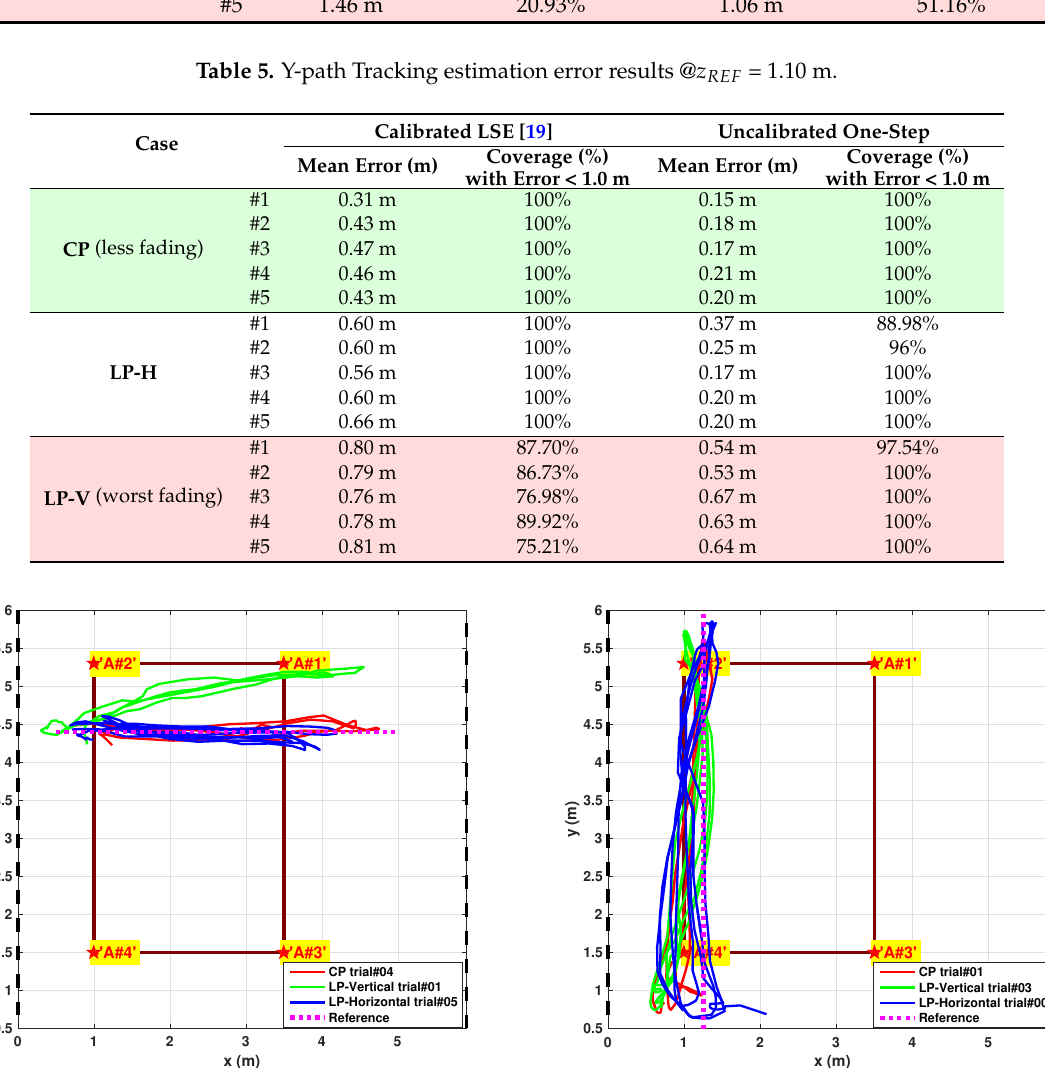
Figure 23. Best performing tracking results for X path ( Left ) and Y path ( Right